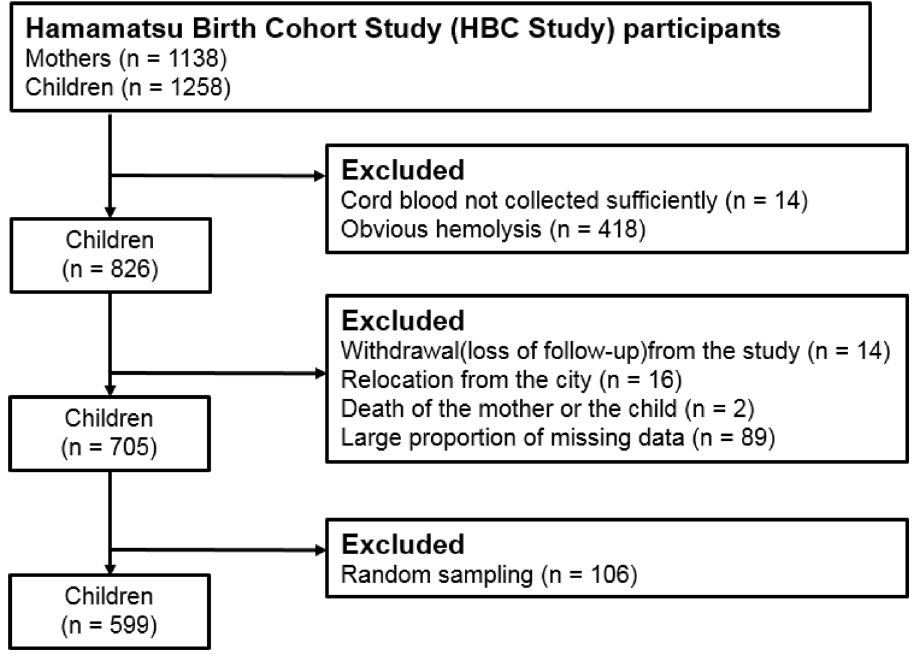
Figure 1. Flow chart of the participant